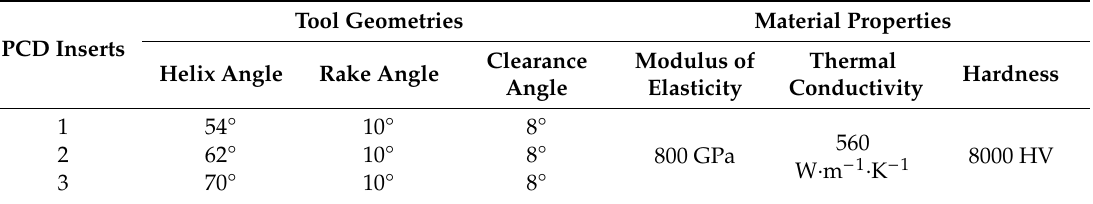
Table 2. Geometries and properties of polycrystalline diamond (PCD) inserts.